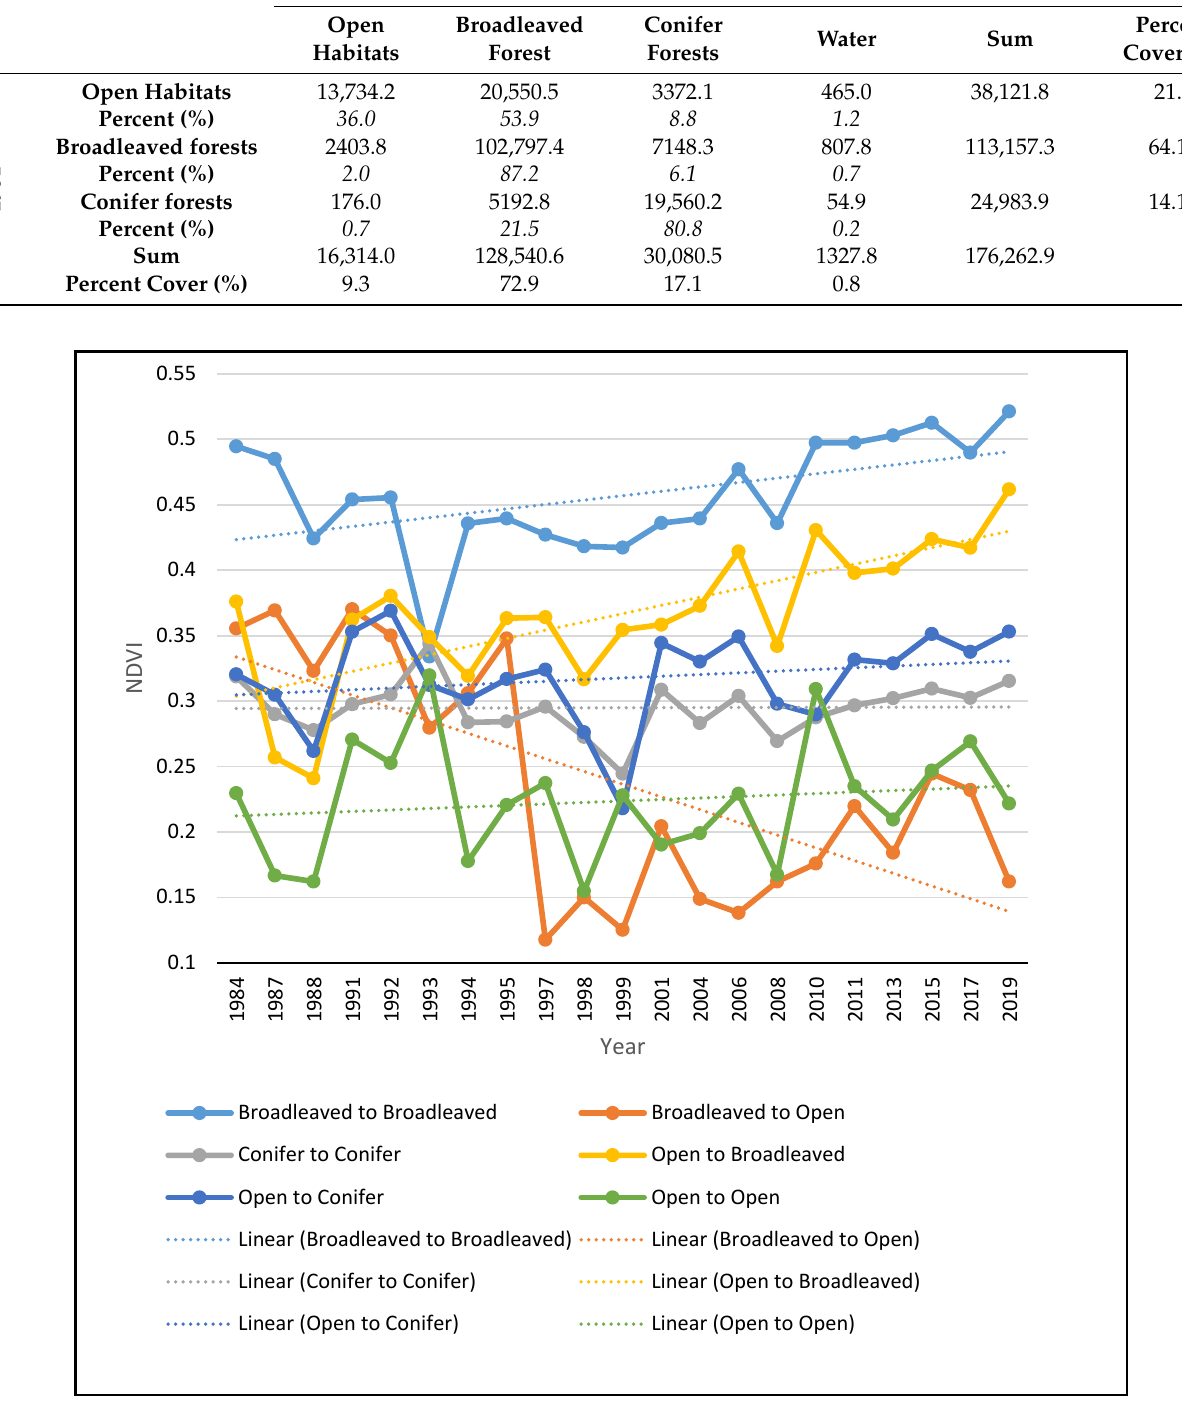
Figure 5. NDVI multitemporal profile of the main transitions observed in the study area.